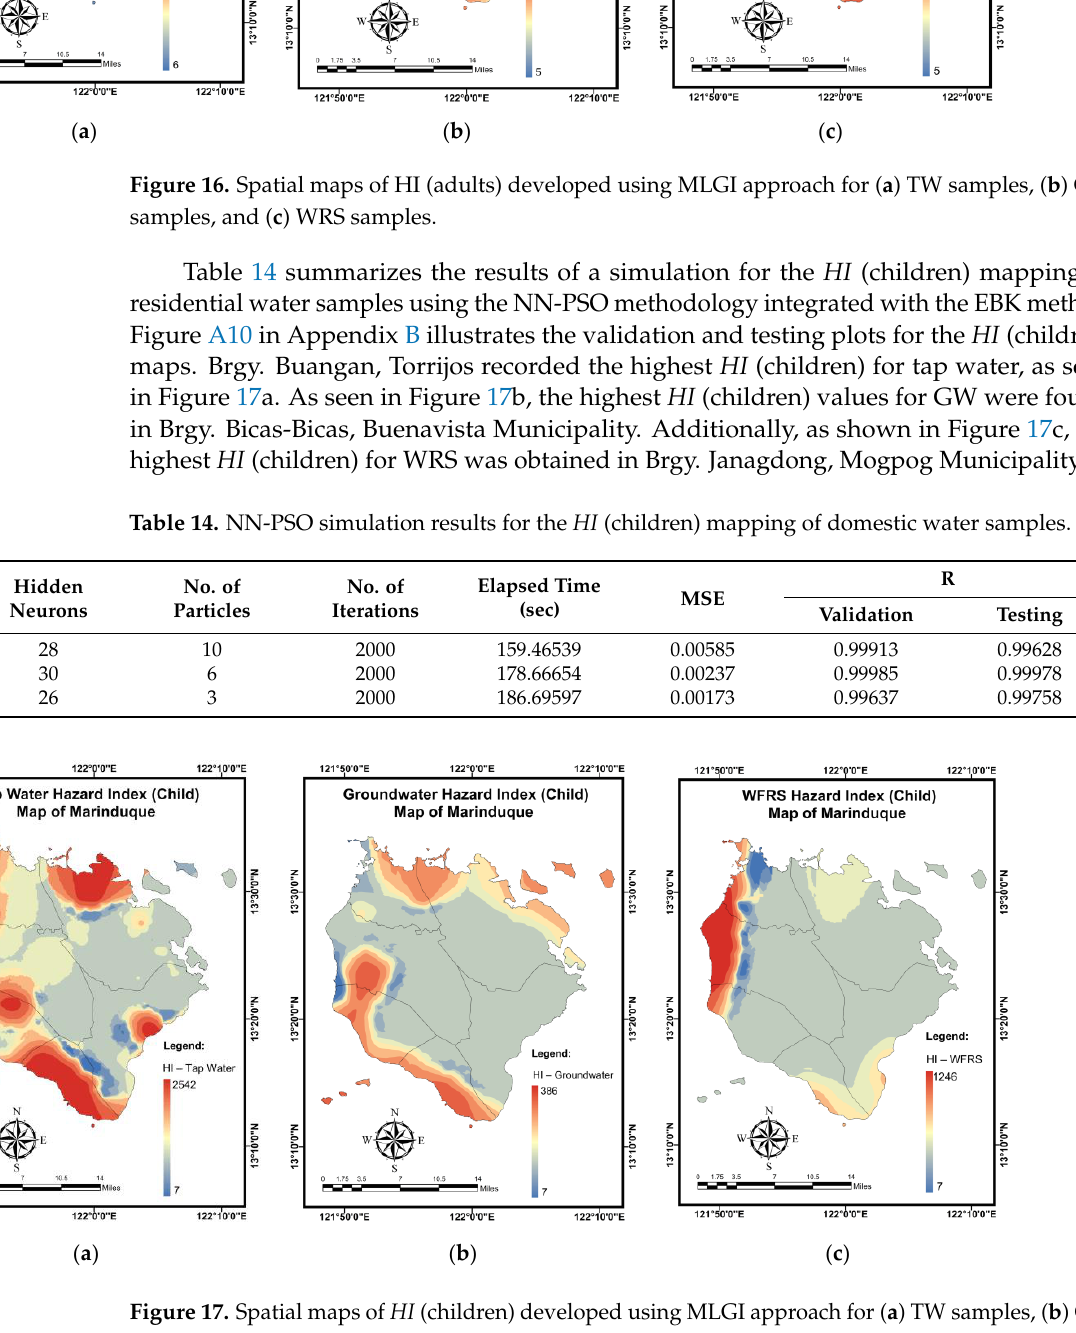
Figure 17. Spatial maps of HI (children) developed using MLGI approach for ( a ) TW samples, ( b ) GW samples, and ( c ) WRS